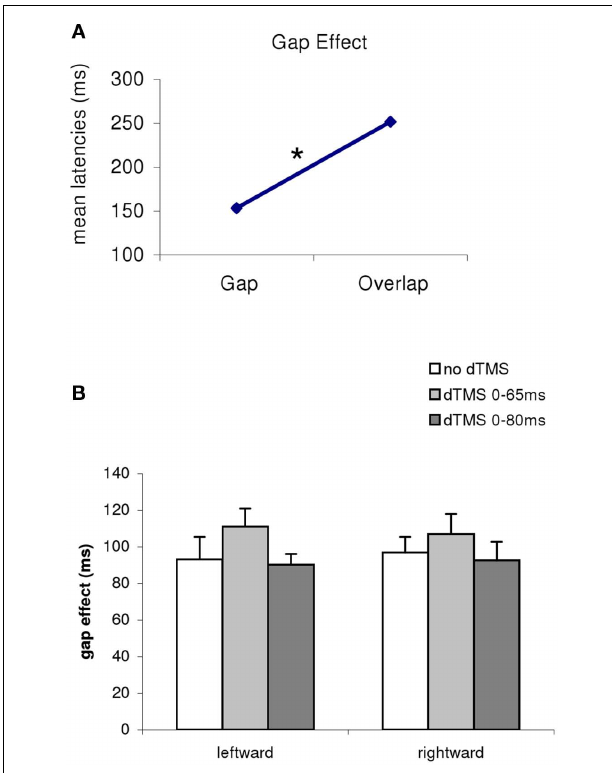
FIGURE 3 | (A) Mean latencies of the group according to the task (gap/overlap), and (B) gap effect for all conditions merged [(B), dTMS, saccade direction]The asterisk indicates a main effect of the gap/overlap task.The magnitude of this effect is 99ms longer in the overlap